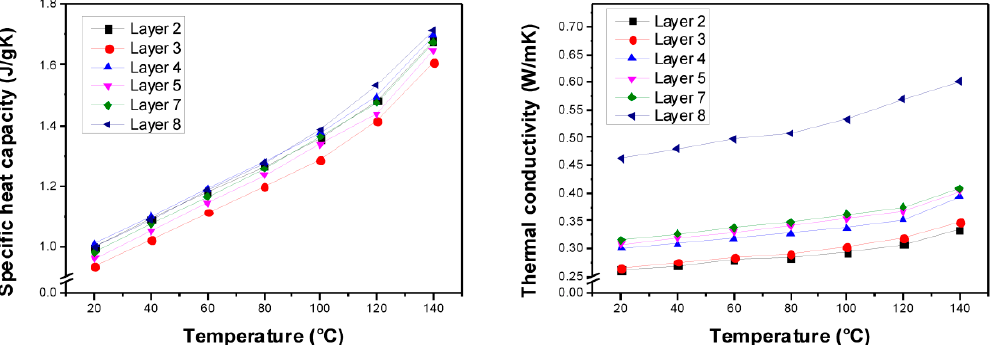
Figure 7. ( Left ) Specific heat capacity measurements for the different layers using differential scanning calorimetry (DSC). ( Right ) Calculated thermal conductivity of the different layers based on the measurements of the thermal diffusivity, the density, and the specific heat capacity.